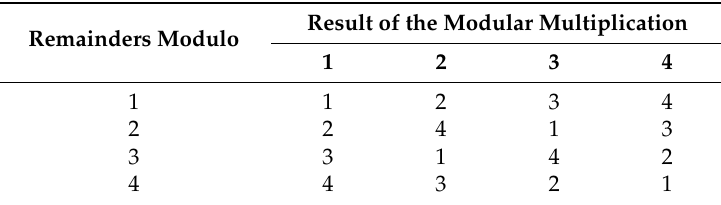
Table 5. Tabular multiplier modulo 5.